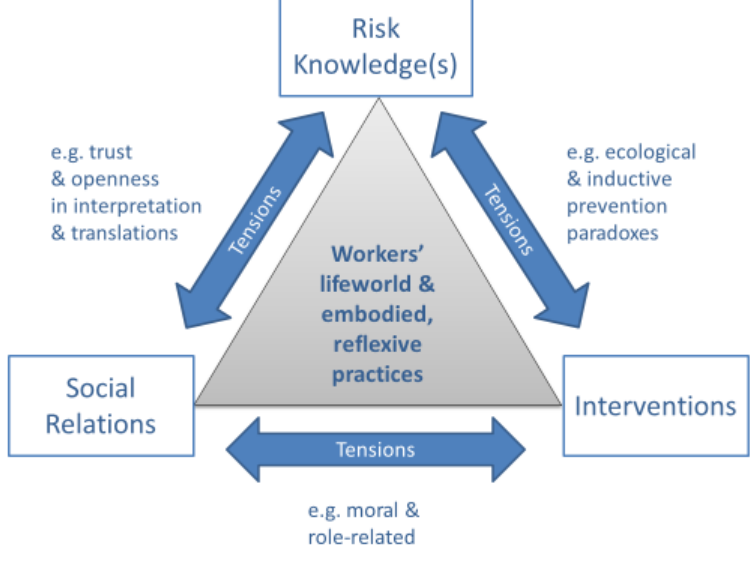
Figure 1 . Core concepts and tensions in risk